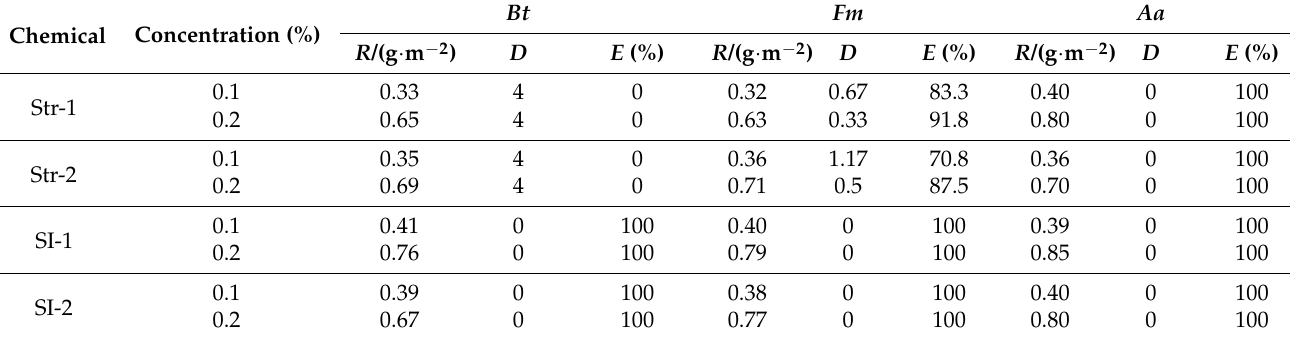
Table 4. Stain resistance of bamboo treated with selected chemicals.